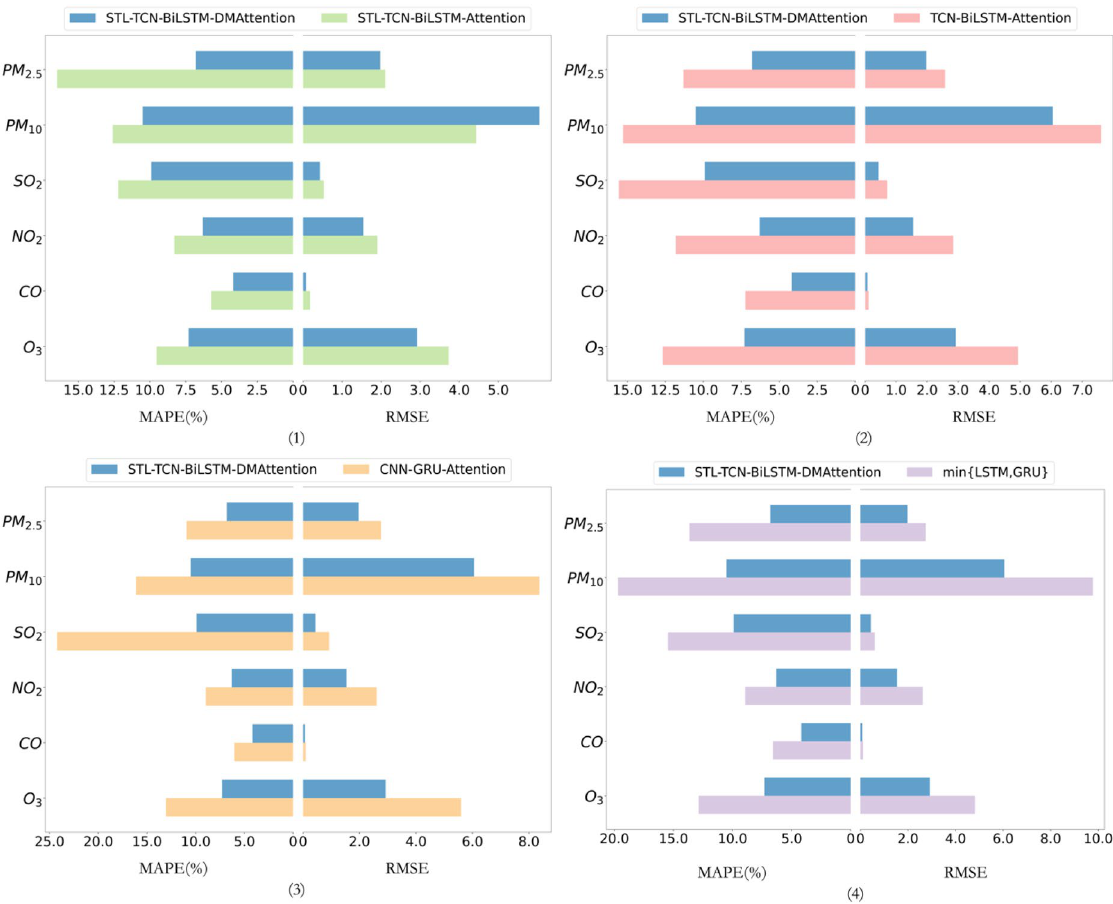
Figure 8. The results of comparative